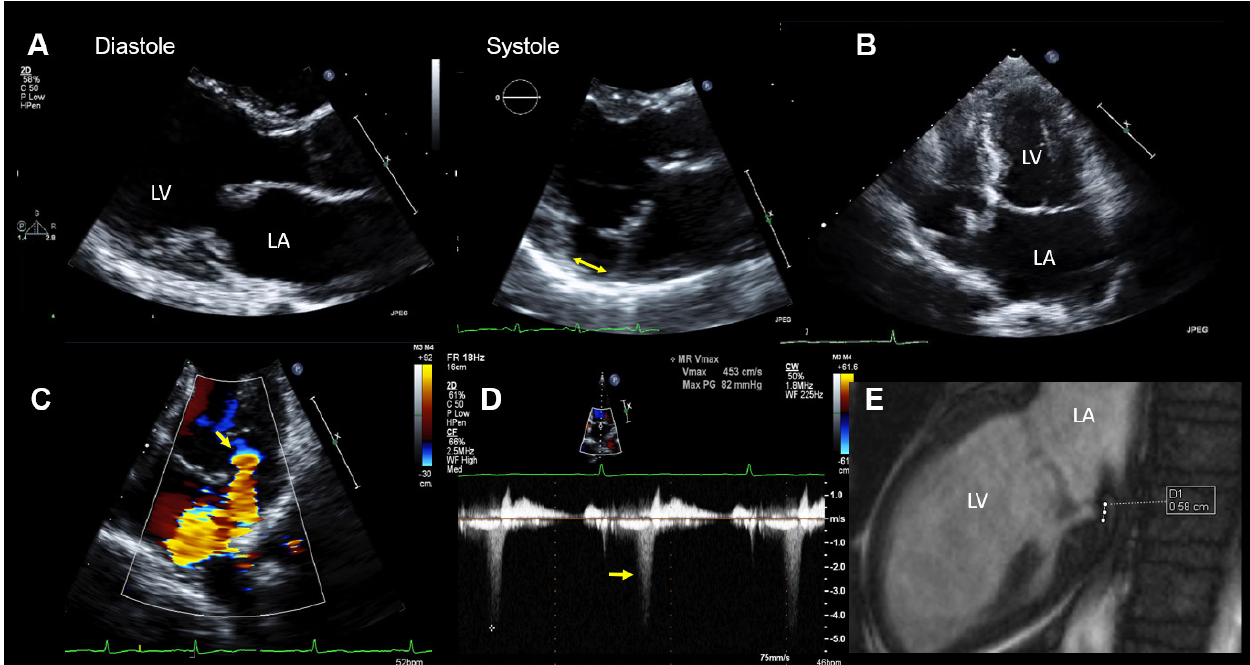
Figure 2. Case 1: Summary of the key findings from multimodality imaging. ( A ) The mitral annular disjunction (MAD) (yellow double arrow) is only visible in systole in a parasternal long-axis transthoracic echocardiography (TTE) view. ( B ) A mildly enlarged left atrium is seen in a 4-chamber TTE view. The MAD is not clearly visualized. ( C ) The proximal isovelocity surface area (PISA) zone (yellow arrow) is seen. A PISA radius of 4 mm and a vena contracta of 3.5 mm indicated nonsevere mitral regurgitation (MR). ( D ) MR occurs only in the late-systole (yellow arrow) in Doppler imaging. ( E ) The MAD is measured in cardiac magnetic resonance imaging (white dots = 5.8 mm). LA = left atrium and LV = left ventricle.